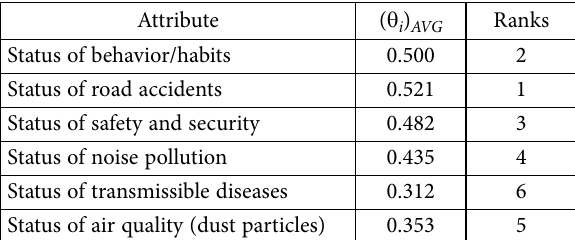
Table 12. Average IFWA value related to lower and upper bound interval